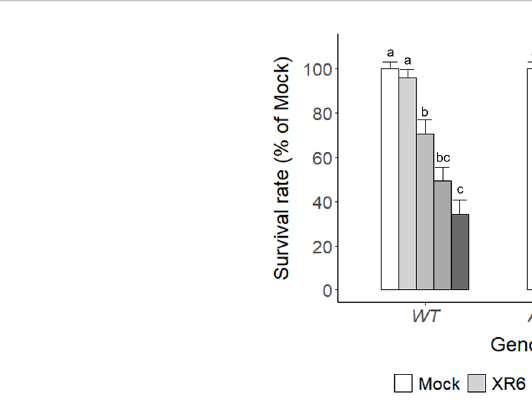
FIGURE 9 Differences in survival rates of wild type and transgenic lines of C. reinhardtii on solid TAP medium after X-irradiation with different doses. The survival rates of X-irradiated cells relative to the mock were calculated by counting the number of colonies on the solid TAP medium 7 days after X-irradiation with 6, 12, 25, or 50 Gy. WT, wild type. XR6, XR12, XR25, and XR50 represent X-rays of 6, 12, 25, and 50 Gy, respectively. Data represent the mean ± standard error (SE) with n = 6 from two independent experiments. Different letters indicate signi fi cant differences at p < 0.05 (one-way analysis of variance followed by Tukey ’ s honestly signi fi cant difference